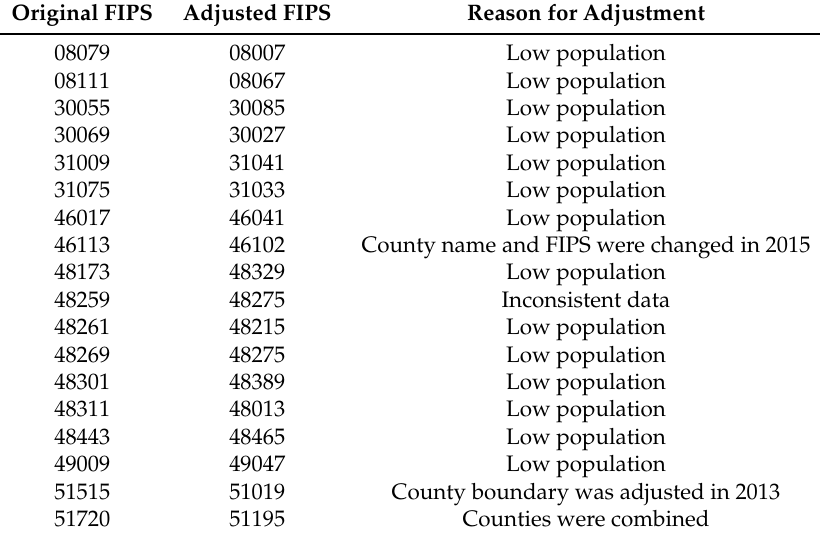
Table A1. FIPS county